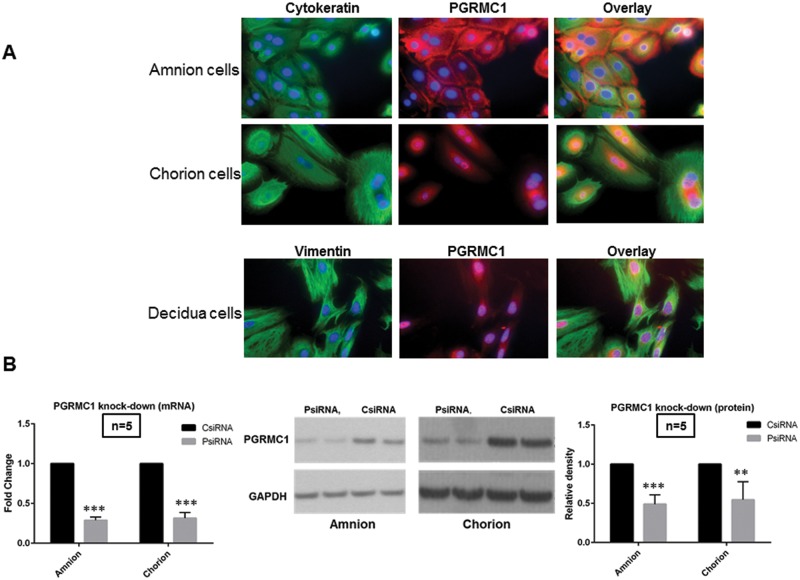
A, Immunofluorescence staining of the biomarkers of fetal membrane cells and PGRMC1. Above 95% of amnion and chorion cells stained positive for their biomarker cytokeratin (green). Amnion and chorion cells appear to be epithelial cell phenotype. Above 95% of decidua cells stained positive for their biomarker vimentin (green). Decidua cells demonstrated typical stromal cell phenotype. All cells stained positive for PGRMC1 (red). PGRMC1 protein in amnion cells is mainly localized to the cell membrane and cytoplasm. In contrast, the expression of PGRMC1 protein in chorion and decidua cells is mainly localized to nuclear and perinuclear space. DAPI counterstaining was performed to visualize nuclei (blue). Images of cells were captured using digital camera interfaced with a fluorescence microscope. Magnification is 40. B, PGRMC1 mRNA and protein knock-down in amnion (A) and chorion cells (C). PsiRNA is for PGRMC1 siRNA transfected group; CsiRNA is for control siRNA transfected group. qPCR results consistently showed about 70% knockdown of PGRMC1 mRNA production (PsiRNA vs CsiRNA, P<0.0001 for amnion cells, P<0.0001 for chorion cells, n = 5). Representative Western blotting and densitometry data are presented. Western blotting consistently showed above 50% knockdown of PGRMC1 protein production (PsiRNA vs CsiRNA, P = 0.0007 for amnion cells, P = 0.01 for chorion cells, n = 5).